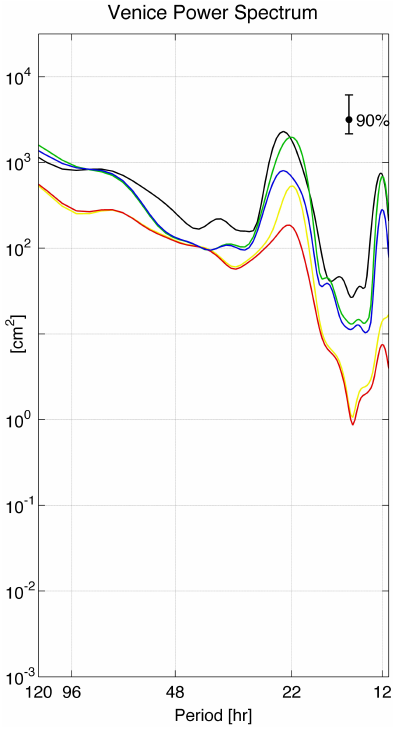
Figure 11. Venice η power spectra from observations and model re- sults. Observations, black; NEMO-MFS1, red; NEMO-MFS2, blue; NEMO-MFS3, yellow; NEMO-MFS4,